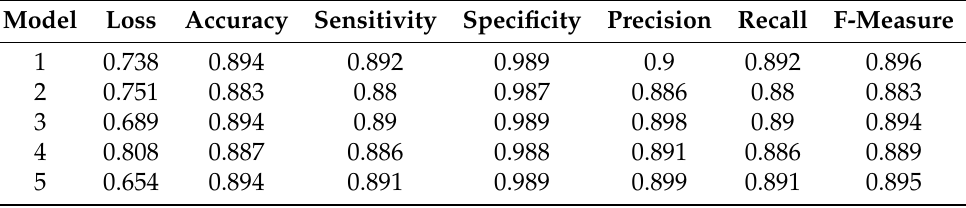
Figure 3. Epochs vs. accuracy graphs. Table 5. Performance of selected models based on Bayesian